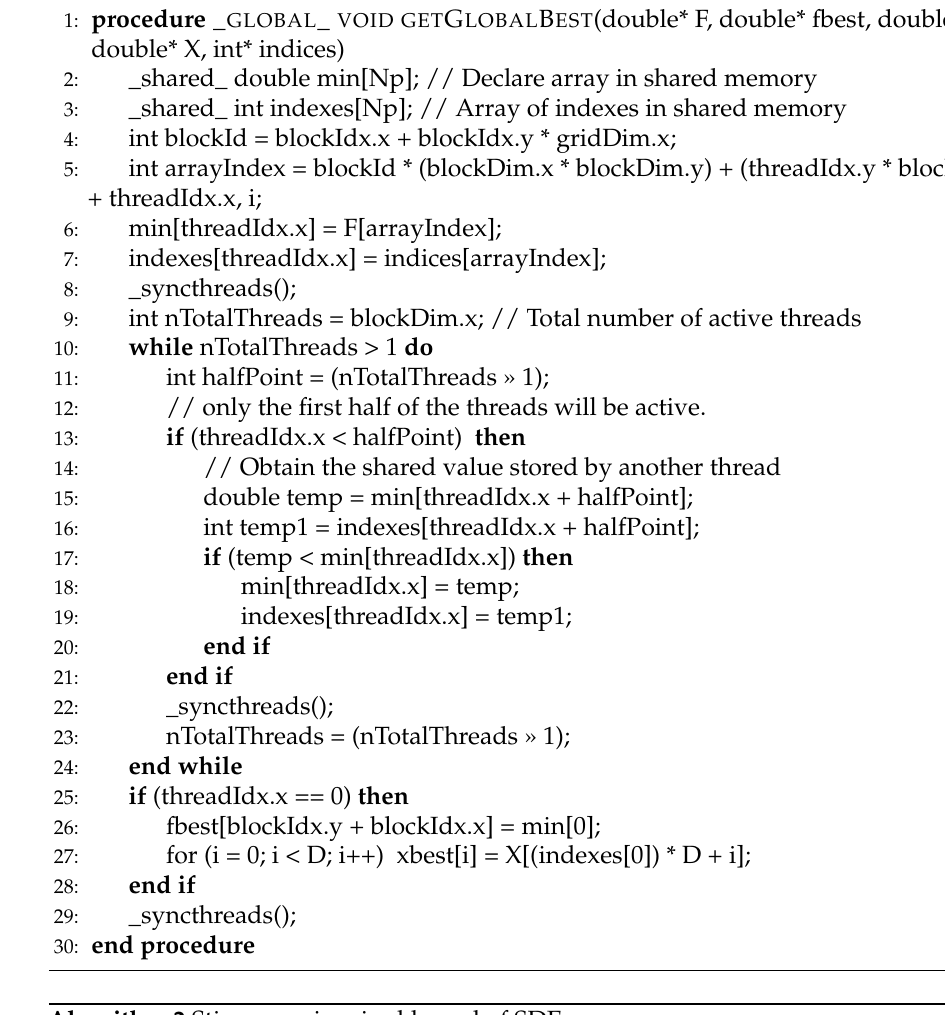
Algorithm 1 Kernel of DE to obtain the global best